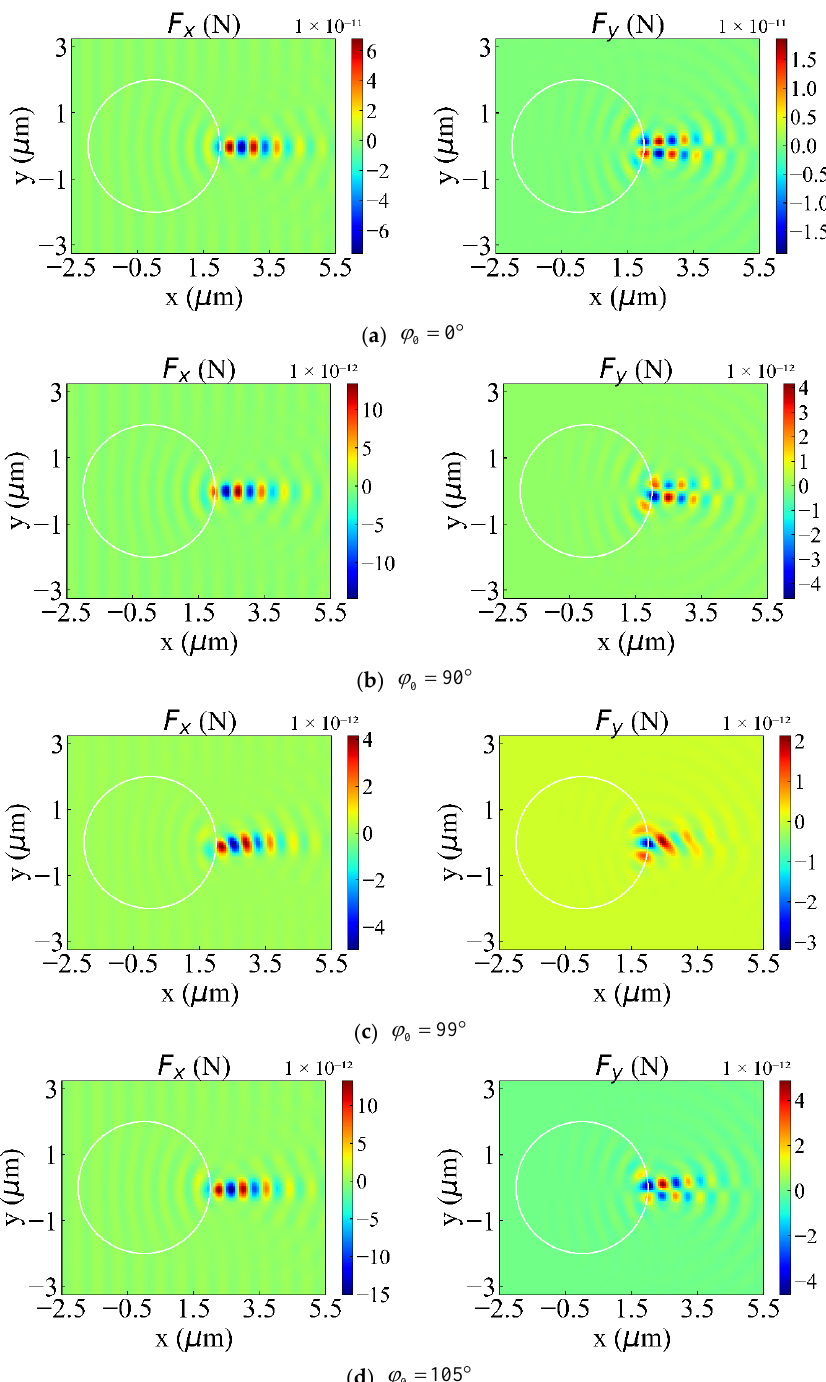
Figure 7. Optical force exerted on a nanorod with different ϕ 0 . Panels ( a – d ) show the optical forces F x and F y when ϕ 0 = 0 ◦ , 90 ◦ , 99 ◦ , and 105 ◦ , respectively.